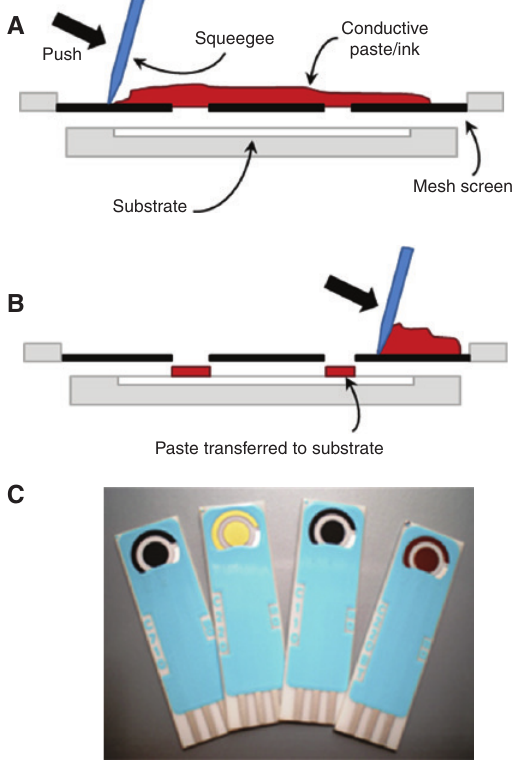
Figure 2: Fabrication of SPE. SPE are produced using conductive pastes/inks and mesh screens. For this, a conductive paste is placed onto the mesh screen and is squeezed over it (A). As a result, the ink passes through the pores in the screen and is printed onto the substrate below it (B). (C) An example of SPE of different materials.